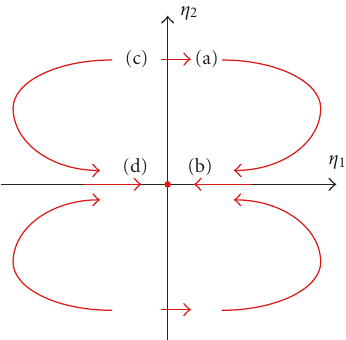
Figure 5: Structure of a candidate vector field for unconstrained